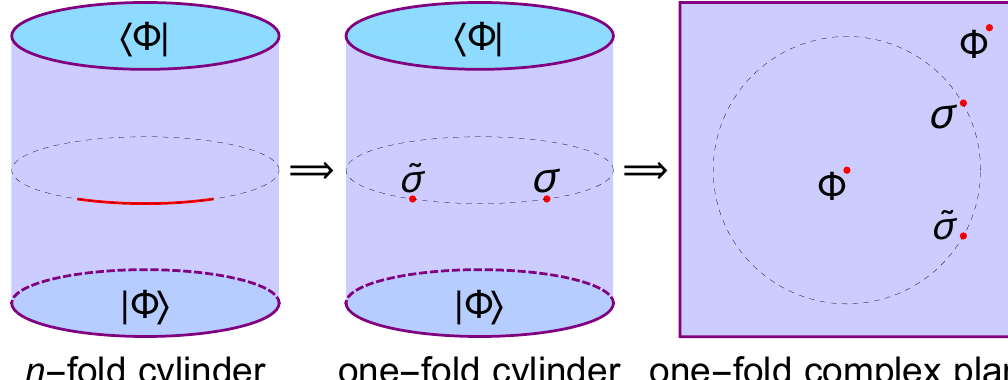
Figure 2 . This (cid:12)gure illustrates how OPE of twist operators on a cylinder and that on a complex plane are related. The one-fold CFT on a one-fold CFT on an n -fold cylinder is equivalent to an n -fold CFT on a one-fold cylinder. The boundary conditions of the n -fold CFT can be replaced by the insertion of a pair of twist operators [22]. The cylinder with twist operators can be mapped to a complex plane with twist